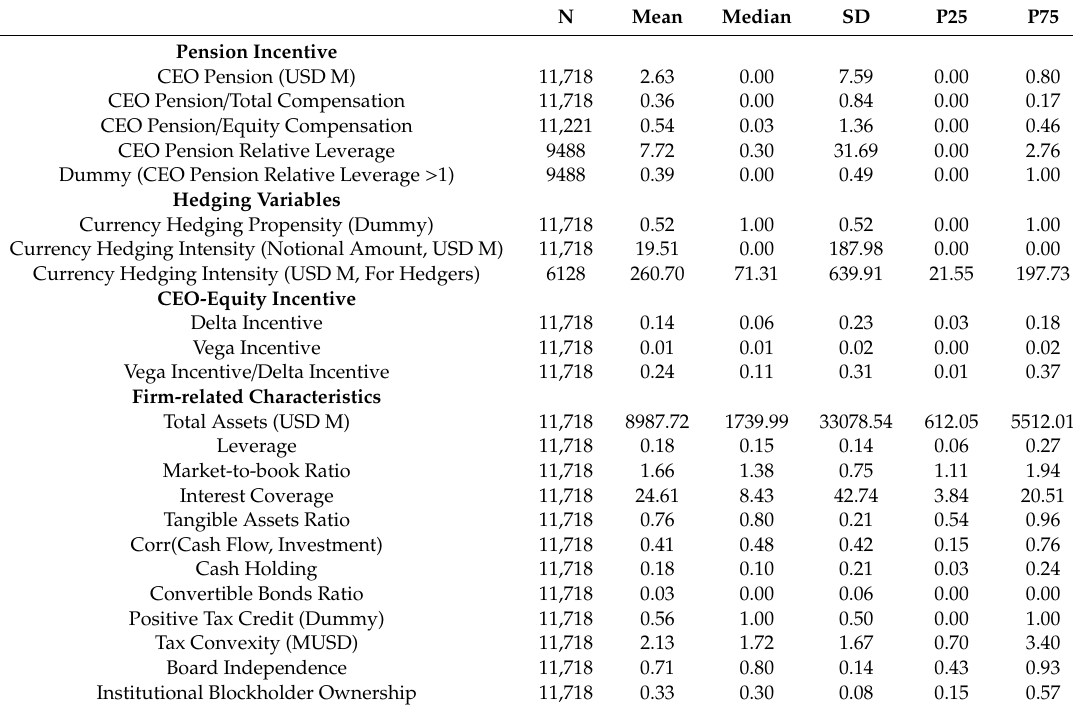
Table 1. Summary statistics.